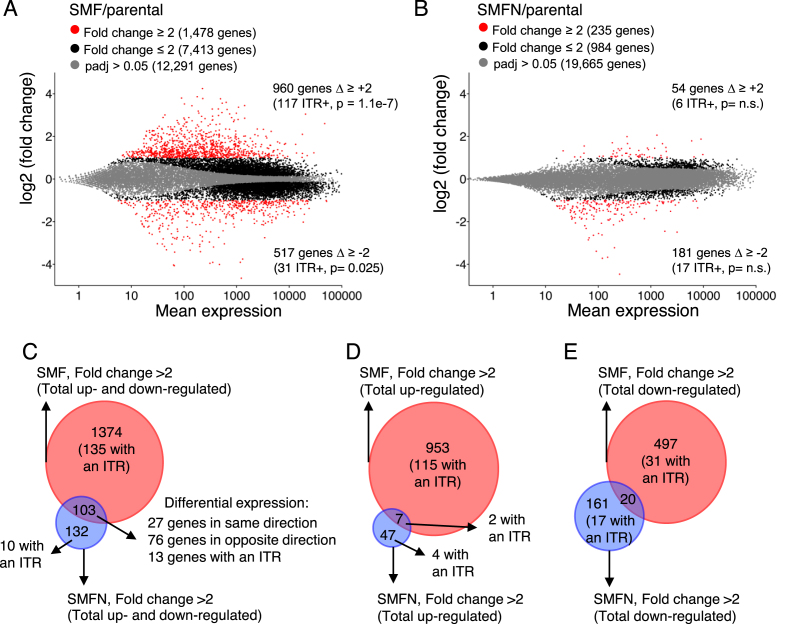
SETMAR regulates gene expression and is dependent on its methyltransferase activity. (A and B) Smear plots of RNA-seq data showing average gene expression versus log2-fold change in gene expression. Fold-change and p values are color coded as indicated. The number of genes up-regulated or down-regulated are indicated at the top and bottom of each graph, respectively. The number of genes with an ITR differentially expressed is indicated between brackets. P-value were determined using a hypergeometric distribution. SETMAR expression is 1372 making it the 9098th most express gene out of 16 776 genes. (C–E) Venn diagrams for the genes significantly differentially expressed more than ±2-fold from parts A and B.